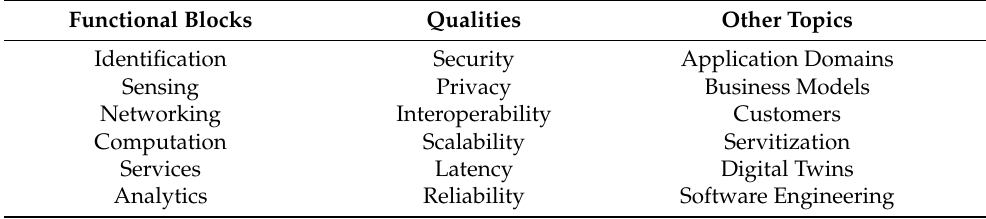
Table 2. Dimensions and topics of the IoT